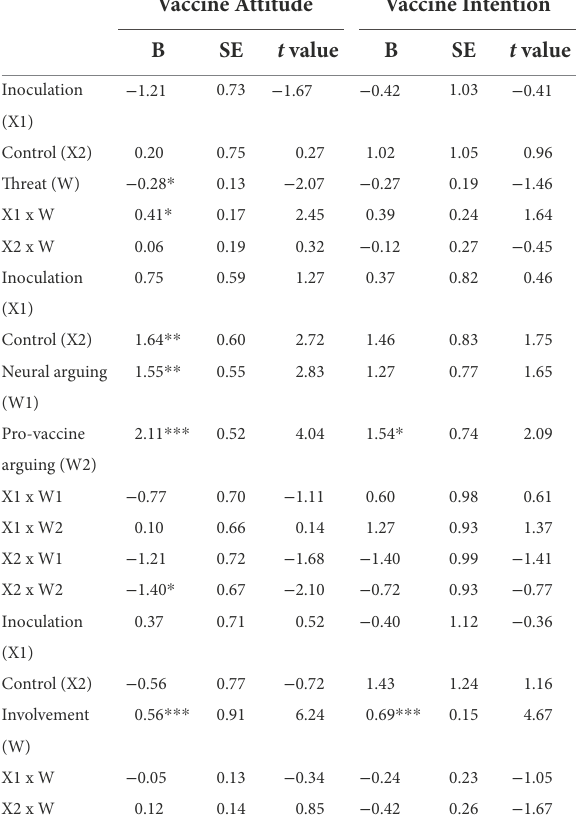
TABLE 3 Moderation analysis.